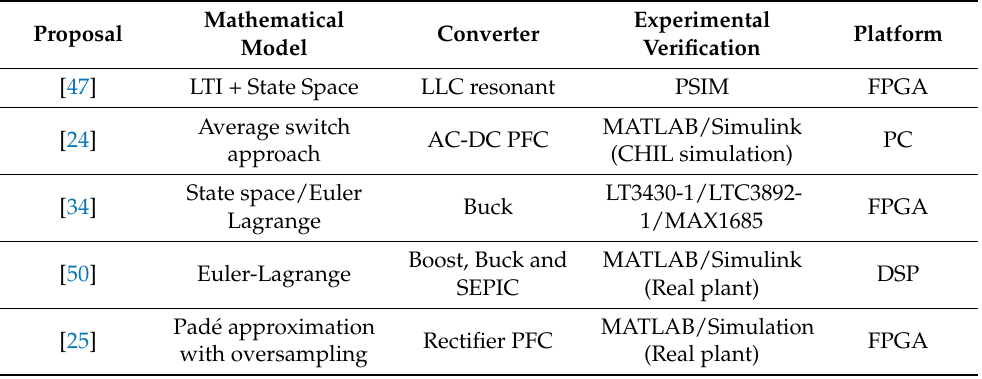
Table 2. Specifications of the proposed